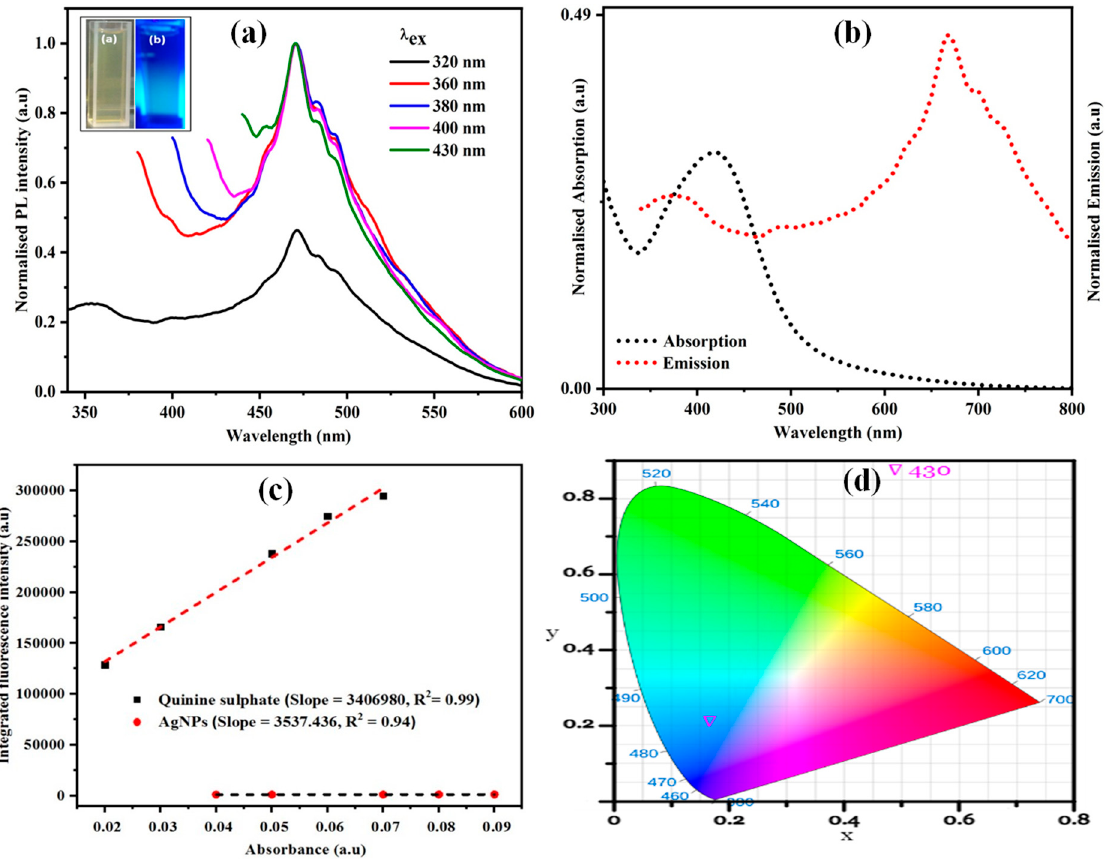
Figure 8. ( a ) Excitation-independent fluorescence emission spectra of green synthesized AgNPs (inset: AgNPs under ( a ) visible light, ( b ) UV light). ( b ) Absorption and emission spectra of green synthesized AgNPs. ( c ) Plot for calculation of quantum yield of AgNPs using quinine sulfate as standard. ( d ) Placement of the AgNPs fluorescence emission spectra on the CIE 1931 chromaticity